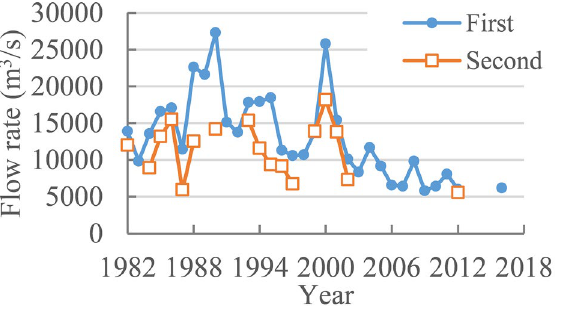
Figure 7. Daily discharge of the Chinese sturgeon during the spawning day downstream of Gezhouba Dam.